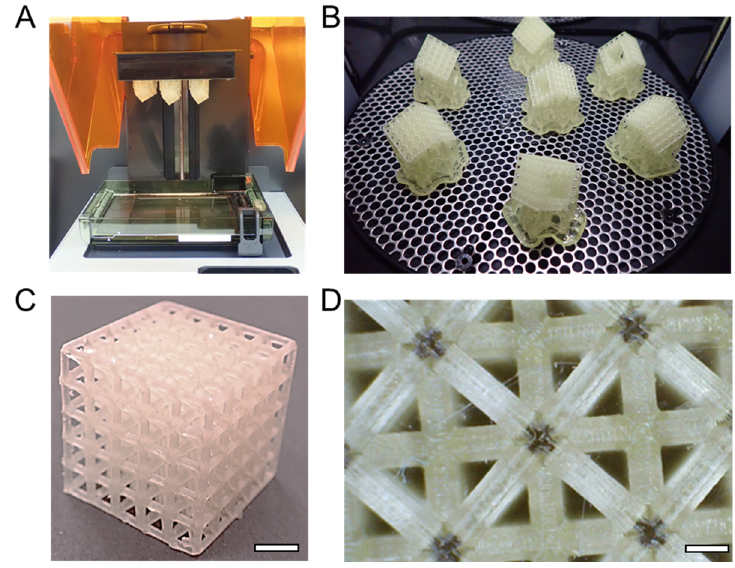
Figure 4. Build process for lattices ( A ) printed with support material on build platform, ( B ) in an ultraviolet curing chamber, ( C ) after post-processing (5 mm scale bar), and ( D ) imaged with microscopy (1 mm scale bar).